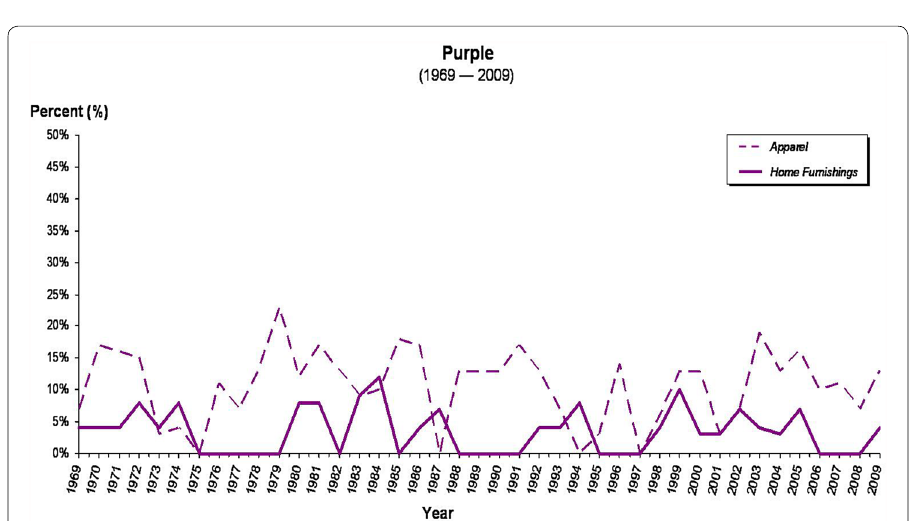
Fig. 4 Purple: incidences of purple in home furnishings and